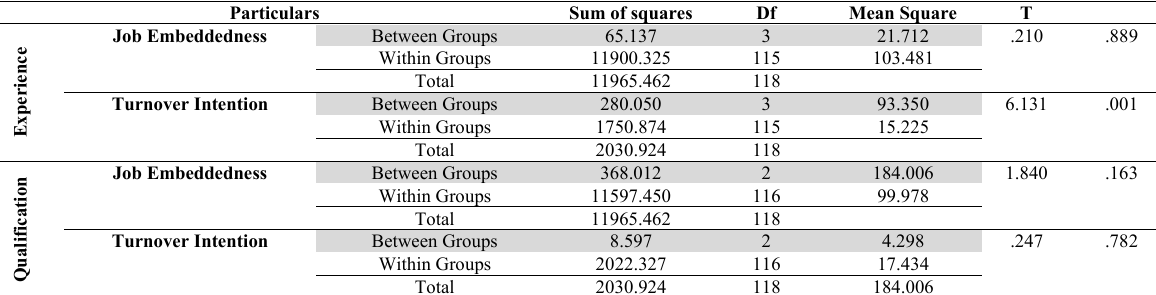
The results of ANOVA